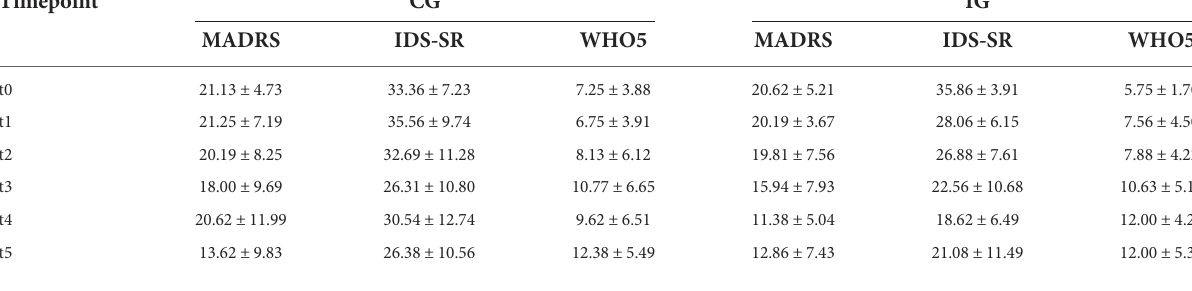
Table 4 for an overview of the statistics.